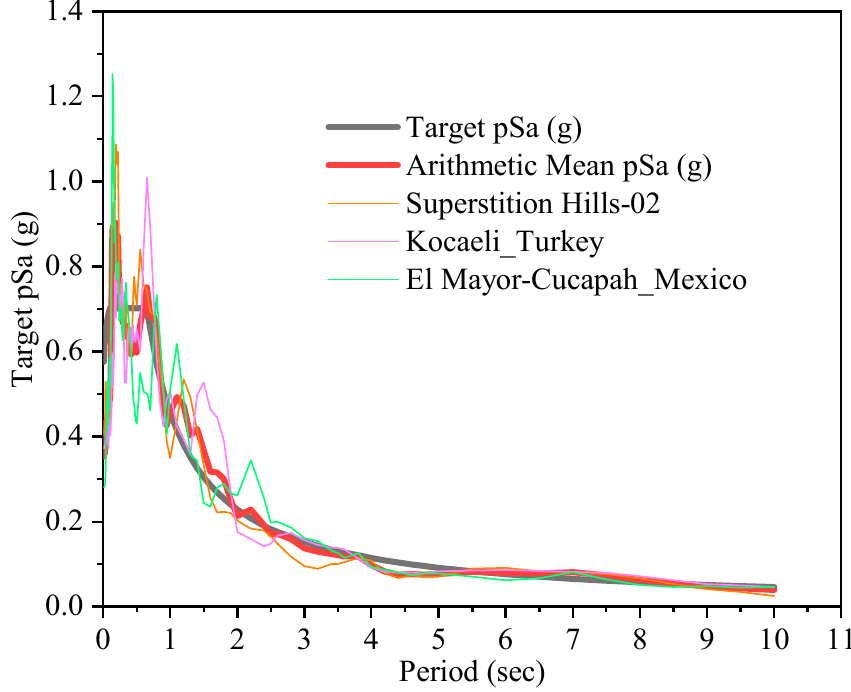
Figure 15. Characteristics of ground motion acceleration response spectrum.